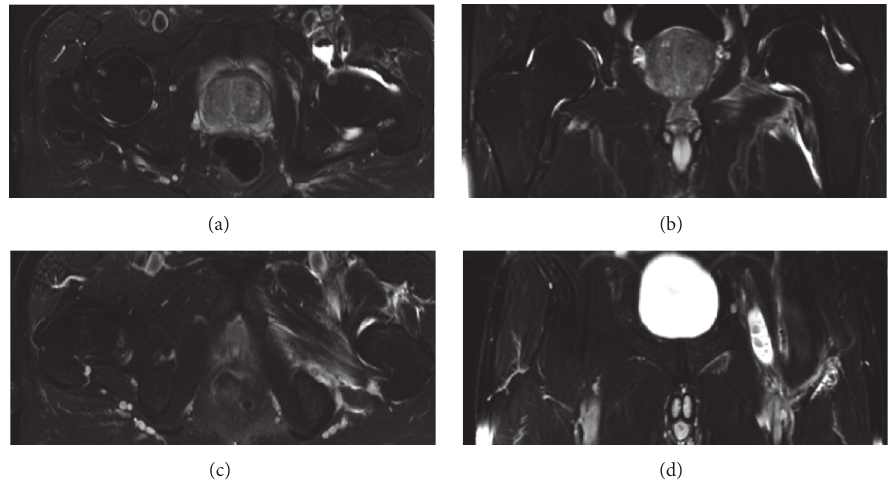
Figure 2: T2 weighted MRI confirms effusion (a, b) with inflammation of the capsule and adjacent muscles and excludes relevant extra- articular abscess formations. Notice the affection of the iliopectineal bursa communicating with the hip joint (a,